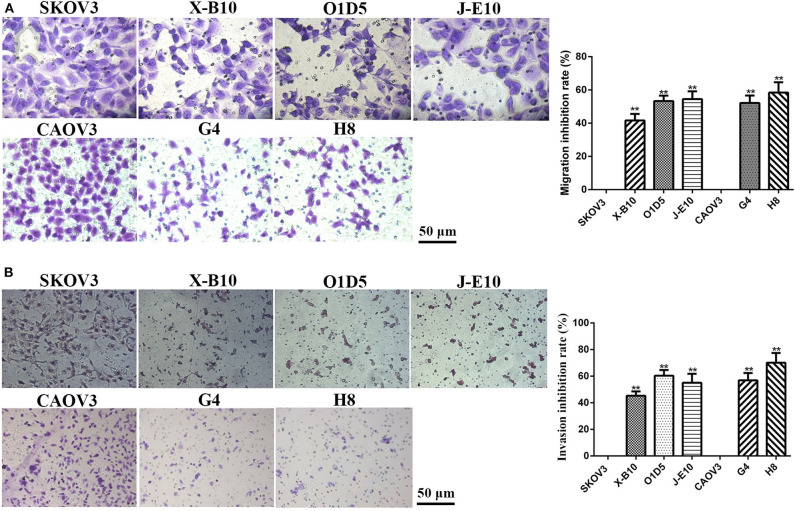
OC-2 KO significantly inhibited the migration and invasion of SKOV3 and CAOV3 cells. The cells suspended in 200 μl of basal DMEM were transferred into the upper chamber while 650 μl of DMEM with 10% FBS was added in the bottom. Matrigel was only used in the invasion assay. The migrated and invaded cells were fixed, stained, imaged, and calculated by ImageJ software in five random fields. (A) Cell migration was assayed by Transwell. (B) Cell invasion was analyzed by Transwell-Matrigel assay. Scale bars, 50 μm. Left panel, representative images. Right panel, statistical analysis of migrated and invaded data. **P < 0.01.